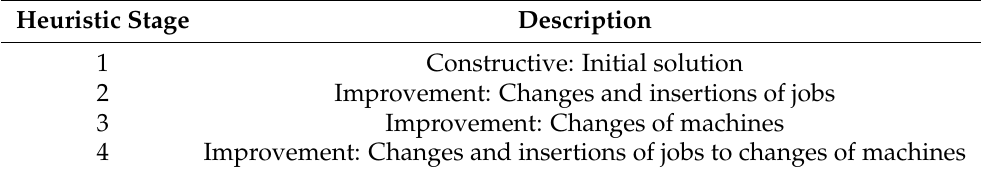
Table 6. Stage codes of the heuristic.